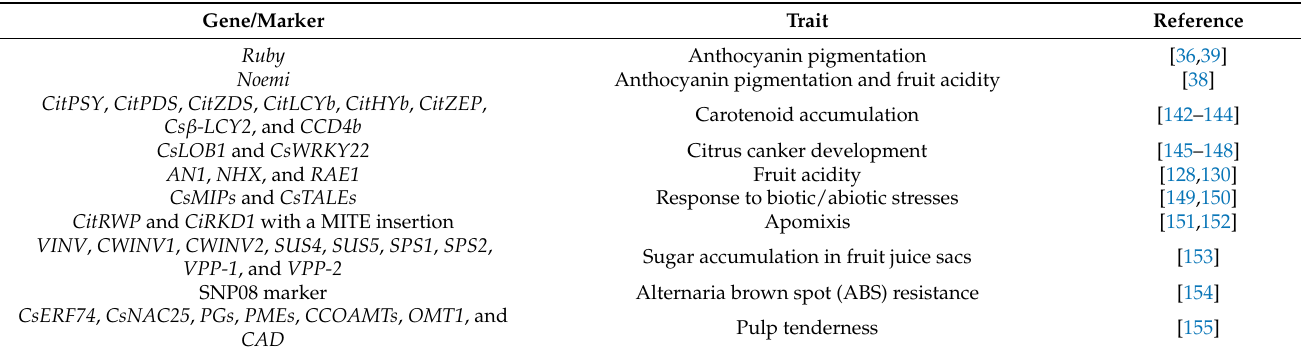
Table 4. Genes/markers regulating important traits in sweet